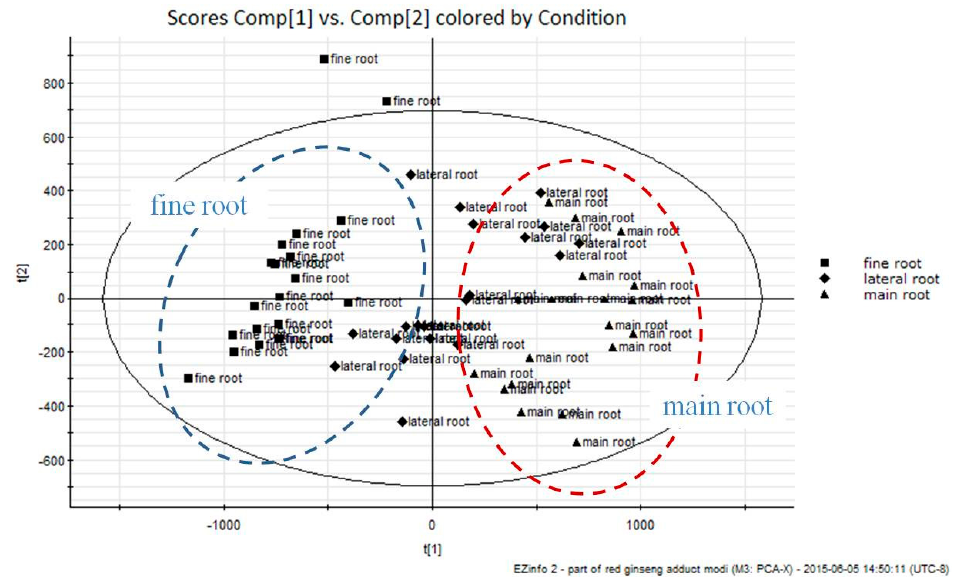
Figure 2. Principal component analysis (PCA) score plot for main roots and fine roots.